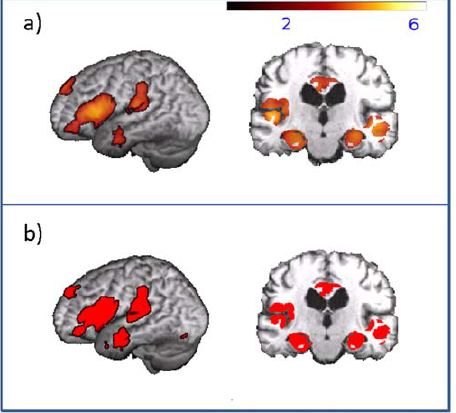
Figure 5. Effect of healthy aging on VBM results in AD. a) Regions showing an age-related GM atrophy in healthy control subjects detected in a correlational analysis using VBM (p=0.001 uncorrected on voxel level and p=0.05 FWE corrected on cluster level) plotted onto an averaged brain. Color bar represents the t-values for the correlation. b) Overlap of regions (in red) showing GM atrophy in old AD patients compared to the control group, without age included as covariate, and regions detected in the correlational analysis showing an age-related GM decline in the control group. Results are plotted onto an averaged brain. Only regions which exceeded the significance threshold (p=0.001 uncorrected on voxel level and p=0.05 FWE corrected on cluster level) in both analyses are shown. AD Alzheimer’s disease, FWE family-wise error, GM grey matter, VBM voxel-based morphometry. Radiological convention.